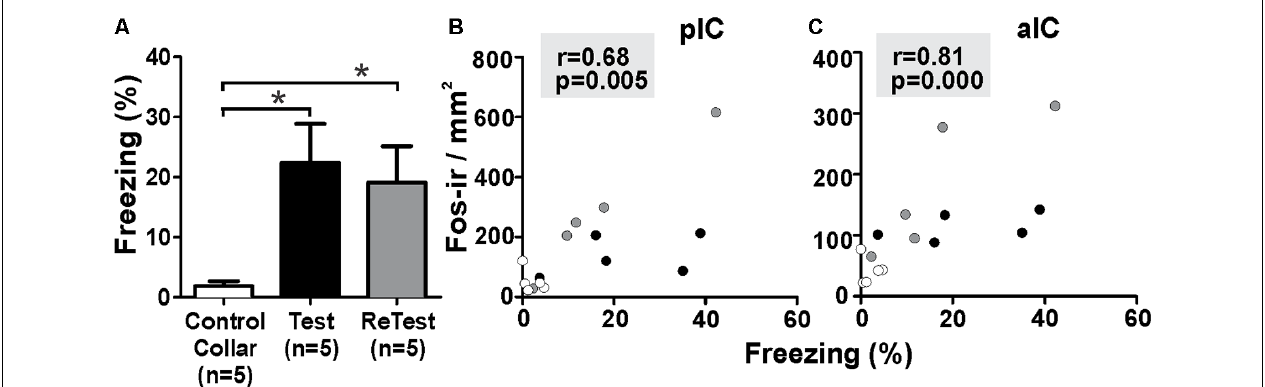
FIGURE 6 | Fos expression in the insula cortex was highly correlated with freezing behavior. (A) Rats exposed to cat odor showed higher levels of freezing relative to the control collar condition during either the first (Test) or second exposure (ReTest). Data are expressed as means + SEM. ∗ p < 0.05. (B,C) Scatter plots showing the relation between the percentage of time spent freezing and the number of Fos immunoreactive (Fos-ir) neurons in the posterior (pIC) and anterior (aIC) insula cortex for Test and ReTest. Coefficients and p -values are